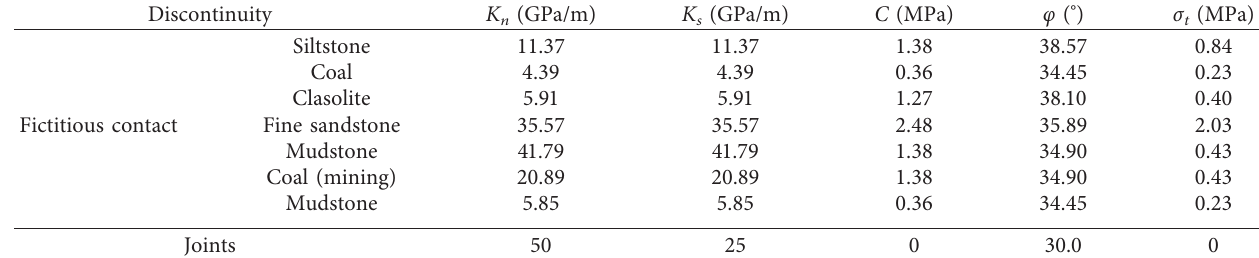
Table 2: Contact properties in the BBM.